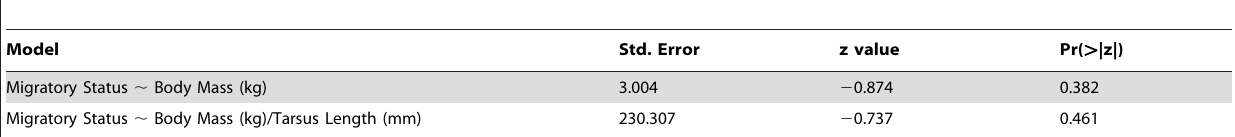
Table 2. Model estimates for effect of body mass and body size index (mass/tarsus length) on migratory status of males.